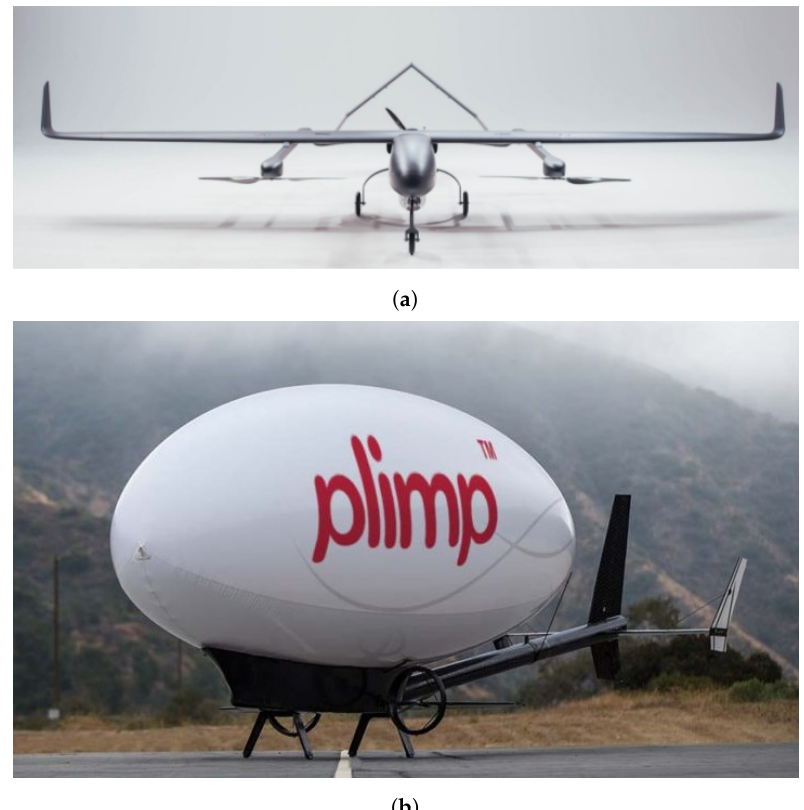
Figure 4. Examples of hybrid unmanned aerial vehicles (UAVs): ( a ) Hybrid vertical take-off and landing (VTOL) fixed-wing. Reproduced, with permission, from Reference [74]. ( b ) Hybrid plane- blimp (PLIMP). Reproduced, with permission, from Reference [77]. Copyrighted 2021 Plimp Airships, protected by national and international patent numbers D727242, D713320, 201815761, 005665221- 0001, and